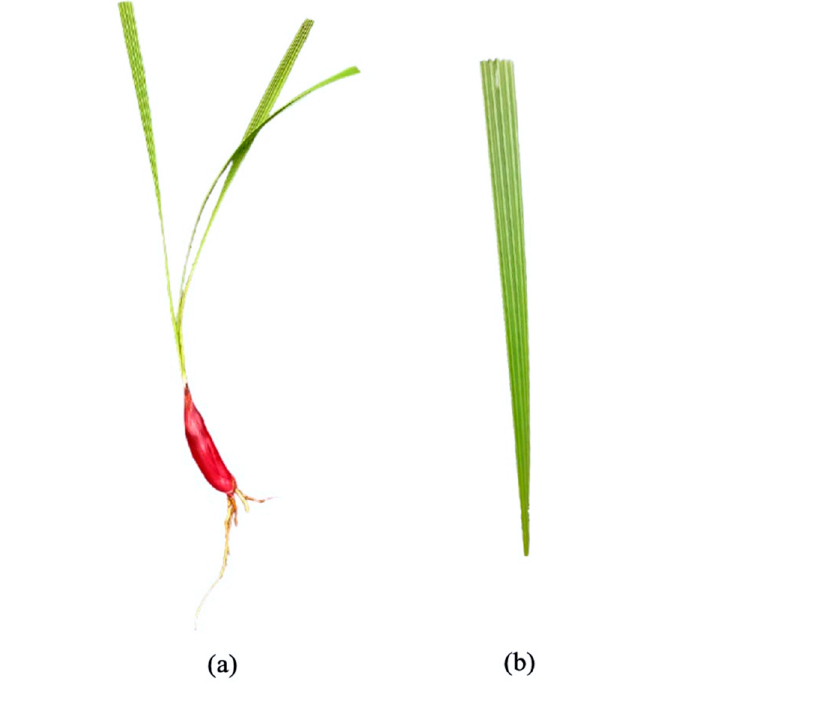
Figure 1. The morphological characteristics of E. bulbosa bulb. Note that it is a rhizomatous long, red bulb that nearly mimics the red onion ( a ) and has a leaf in a pleated linear-lanceolate shape ( b ). 3. Traditional